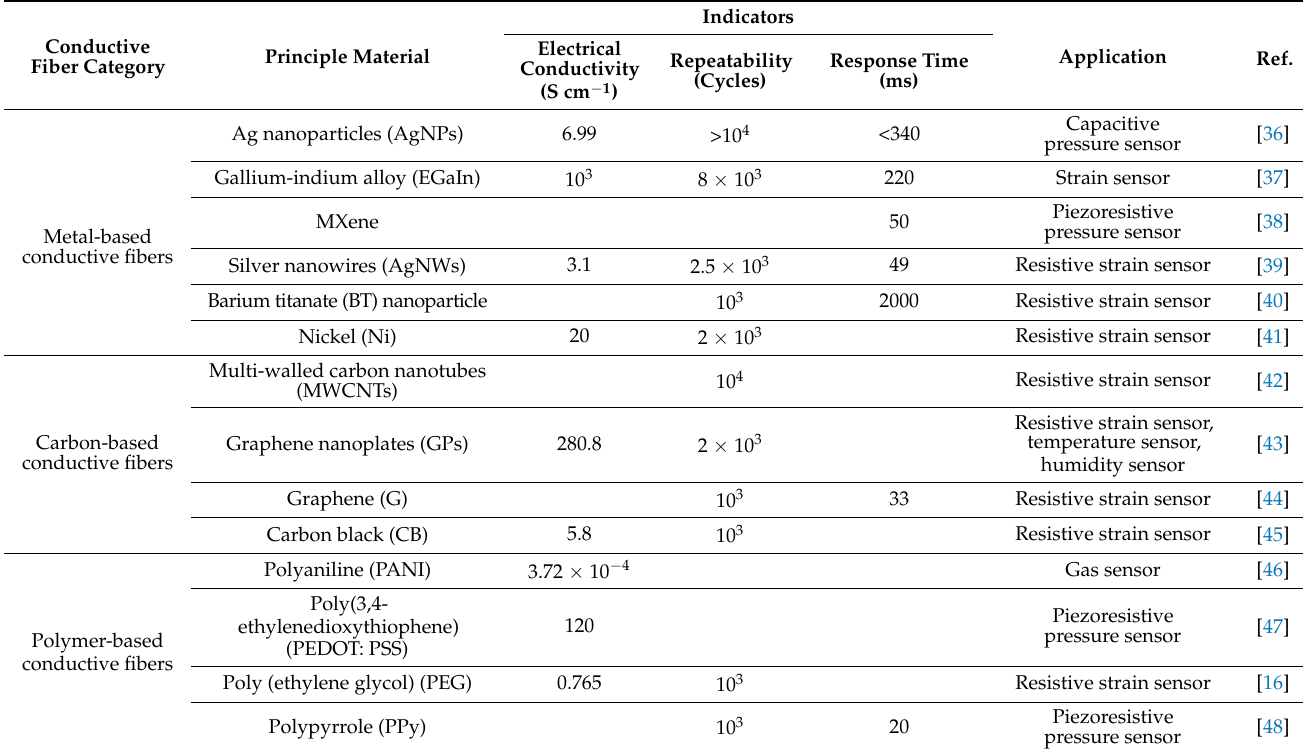
Table 1. Performance parameters of some conductive